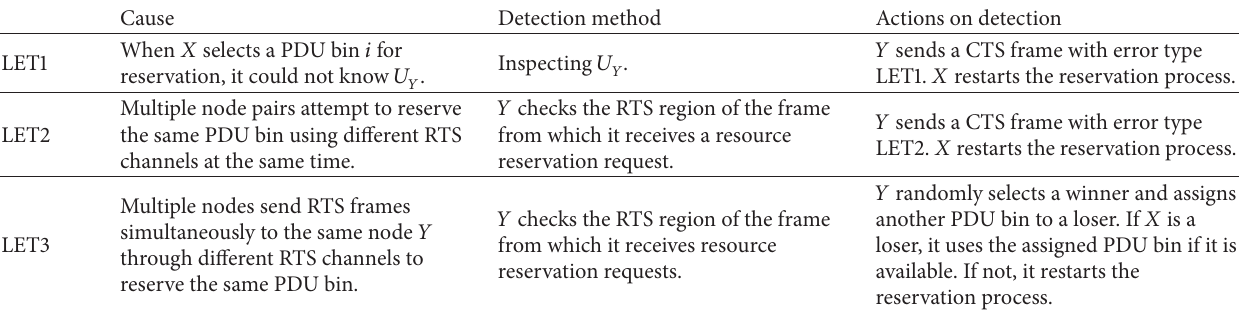
Table 1: The types of logical errors ( 𝑋 : a node requesting a reservation of a PDU bin and 𝑌 : a node receiving a resource reservation request from 𝑋